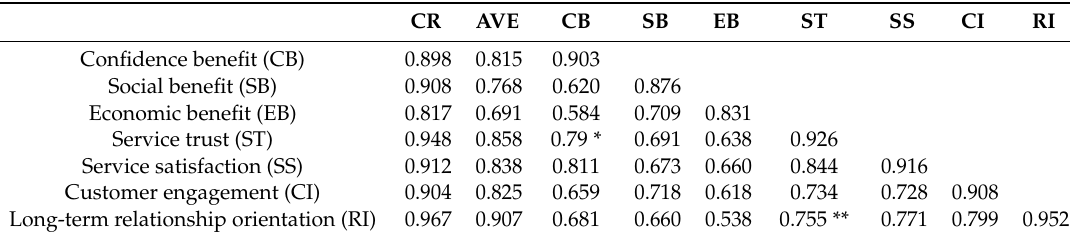
Table 4. Discriminant